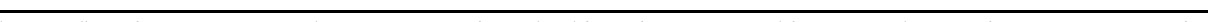
Fig. 3 Small interfering RNA screen indicates RHOQ as a farnesylated factor fostering antiviral function. a Schematic of screening strategy to fi nd out farnesylated anti-viral factors. b HCT-116 cells were treated with negative control (NC) or siRNAs for 24 h, and then infected with M1 virus (MOI = 1). Cell viability was determined 72 h after M1 virus infection. n = 3. Data shown in b , c , f , h were the mean ± SEM. c HCT-116 cells were treated with negative control (NC) or siRNAs for 24 h, and then infected with M1-GFP virus (MOI = 1) for 24 h. M1 virus infection rate was detected by fl ow cytometry assay. GFP expression rate of each gene was normalized to NC. n = 3. d Phase-contrast microscope images of HCT-116 cells after NC or RHOQ siRNAs pretreatment for 24 h and M1 virus infection (MOI = 1) for another 48 h. n = 2. Scale bar: 100 μ m. e M1 virus proteins were detected by western blotting after NC or RHOQ siRNAs pretreatment for 24 h and M1 virus infection (MOI = 1) for another 24 h in HCT-116 and L02 cells. n = 2. f M1 virus titer was measured by TCID50 assay after NC or RHOQ siRNA pretreatment for 24 h and M1 virus infection (MOI = 1) for another 48 h in HCT-116, SW1990, and L02 cells. n = 3. Statistical signi fi cance was using one-way ANVOA. g RHOQ protein expression in four cell lines was detected, including Hep3B, T24, HCT-116, and SW1990 cells. n = 3. h Hep3B, T24, HCT-116, and SW1990 cells were treated with vehicle or Tipifarnib (12.5, 25, 50, 100 nM) and mock- infected or infected with M1 virus (MOI = 1). Cell viability was determined 72 h after M1 virus infection. n = 3. i RHOQ protein was detected after vehicle or M1 virus infection (MOI = 1) for 24, 36, and 48 h in HCT-116. n =